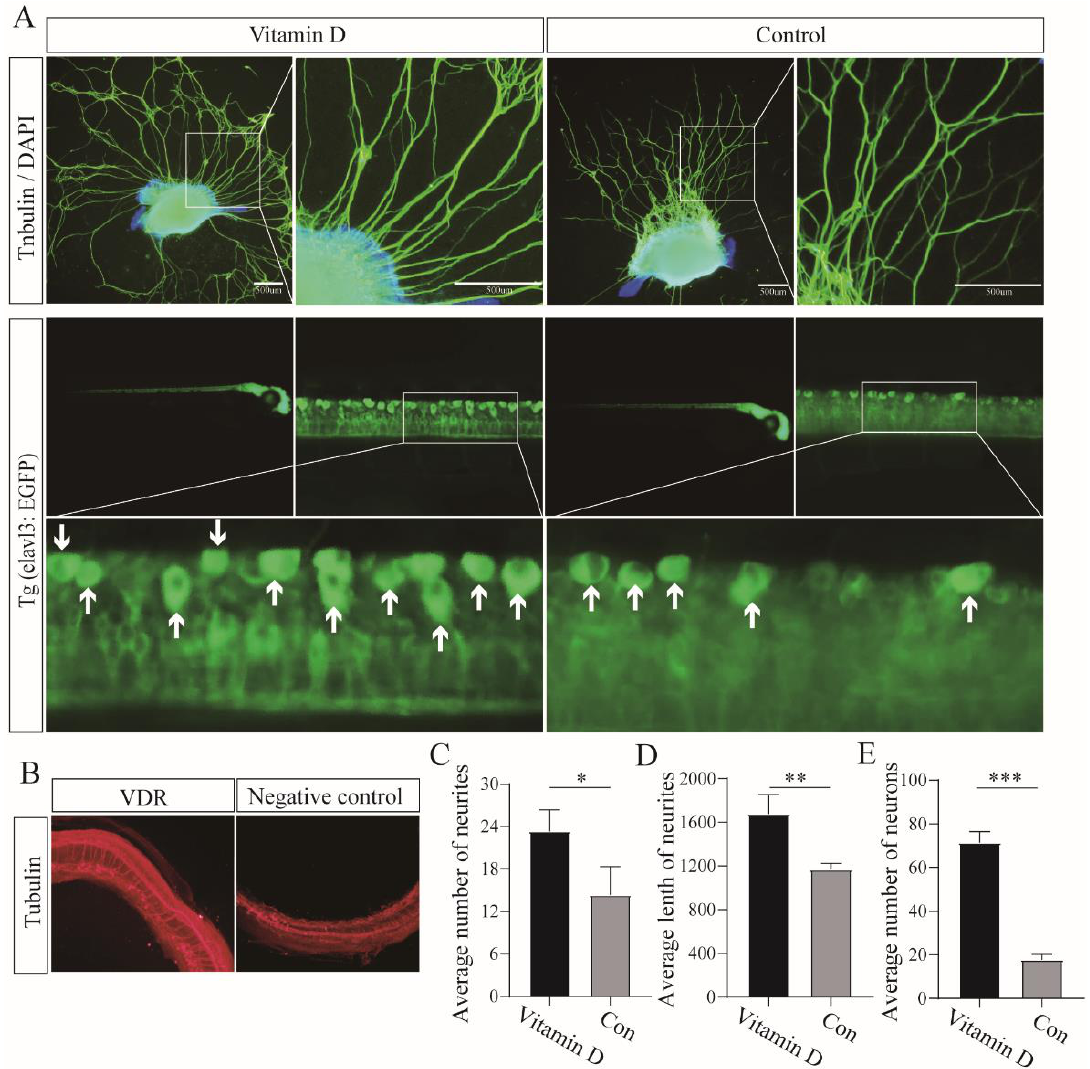
Figure 7. Vitamin D (VD) promotes neuronal survival and neurite growth by binding to VDR and stimulating VDR expression up-regulation. ( A ) Up, SG explants were cultured in 10 nM VD and no added medium for 7 days followed by fluorescence immunostaining analysis. Down, zebrafish larva was maintained in culture medium alone or medium supplemented with 10 nM VD. Arrows indicate complete and countable neurons. ( B ) Fluorescence immunostaining of cochlear explants after transfection with VDR overexpressing lentivirus and negative control lentivirus. ( C , D ) Comparison of average neurite growth length and number between VD-supplemented cochlear explants and control cochlear explants. ( E ) Comparison of the average number of neurons in different treated zebrafish larva. All of the data are presented as the mean ± SD of three independent experiments. *, p < 0.05, **, p < 0.01, ***, p < 0.001 compared with the control.